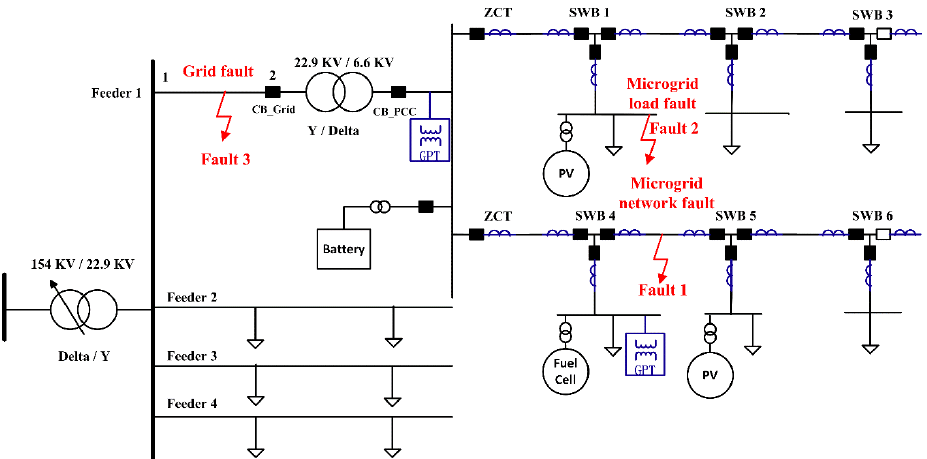
Figure 1. Study of low-inertia microgrid. ZCT, zero-sequence current transformer; PV, photovoltaic; SWB, switchboards.